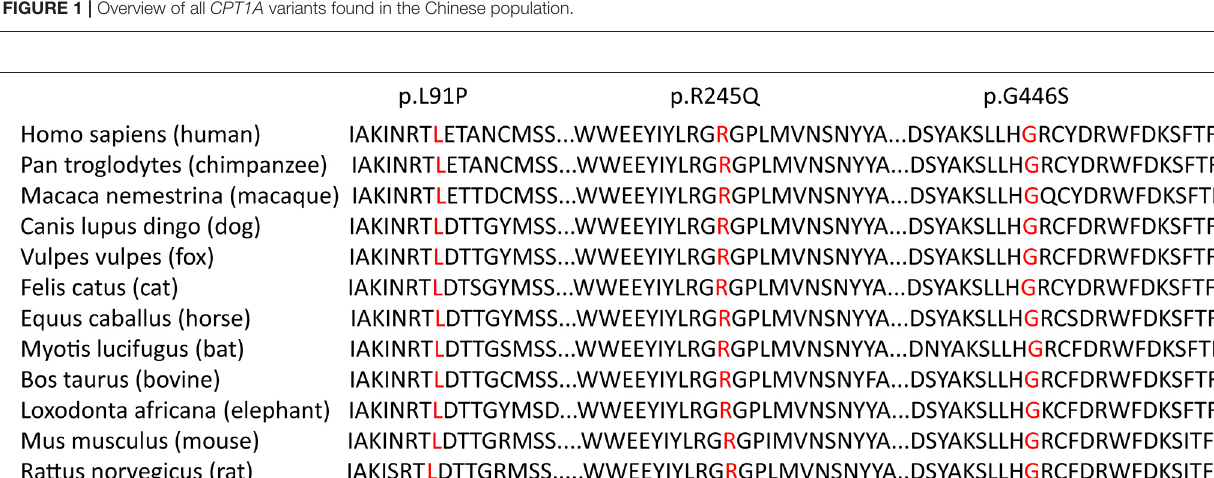
FIGURE 1 | Overview of all CPT1A variants found in the Chinese population.